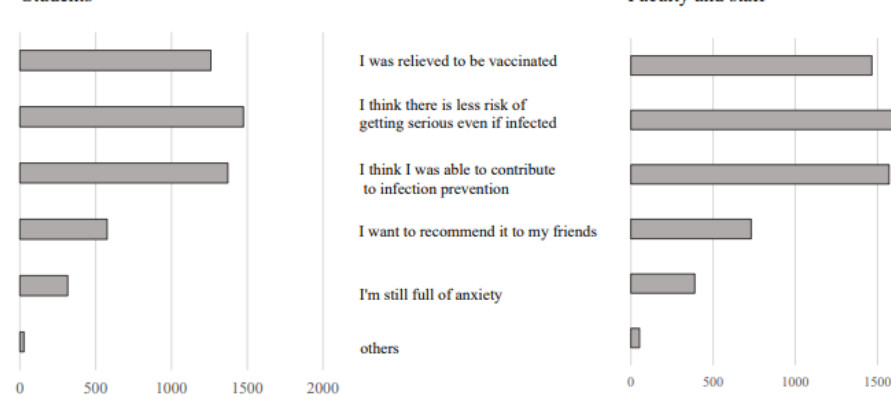
Figure 4. Impressions after vaccination.